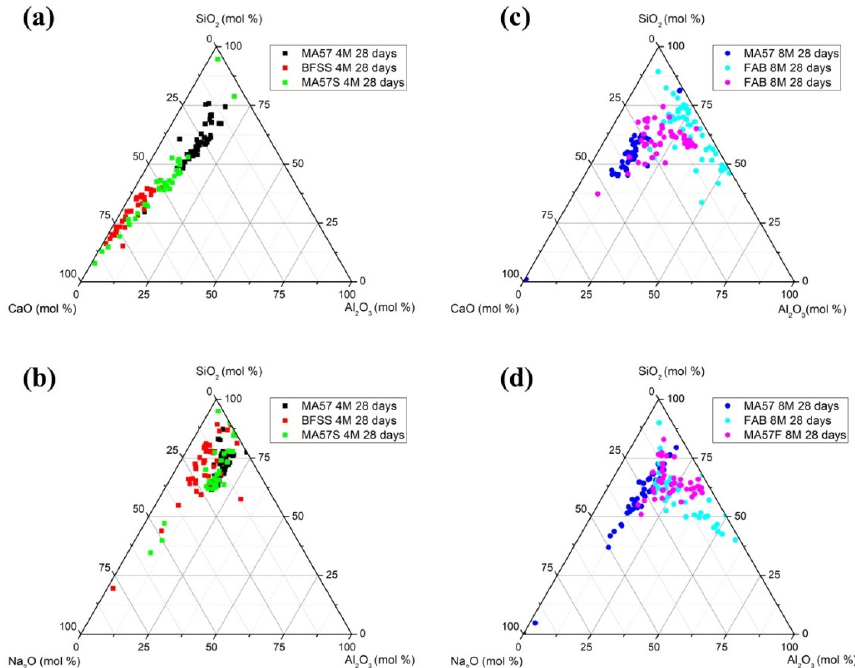
Figure 8. EDS analysis of precipitated gels at 28 days graphed on ( a , c ) CaO-Al 2 O 3 -SiO 2 and ( b , d ) Na 2 O-Al 2 O 3 - SiO 2 ternary diagrams.